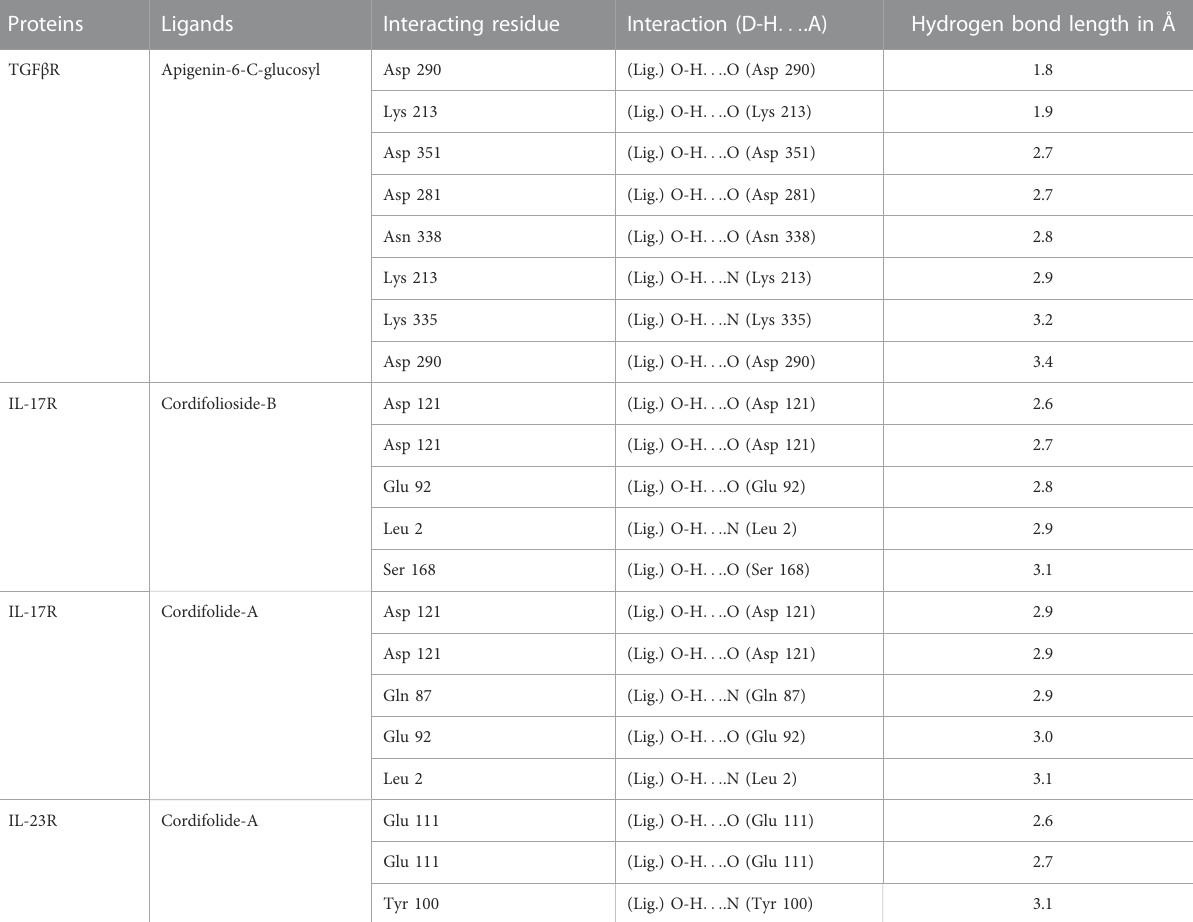
TABLE 2 Representation of hydrogen bonds between TC compounds with some important T cell receptor